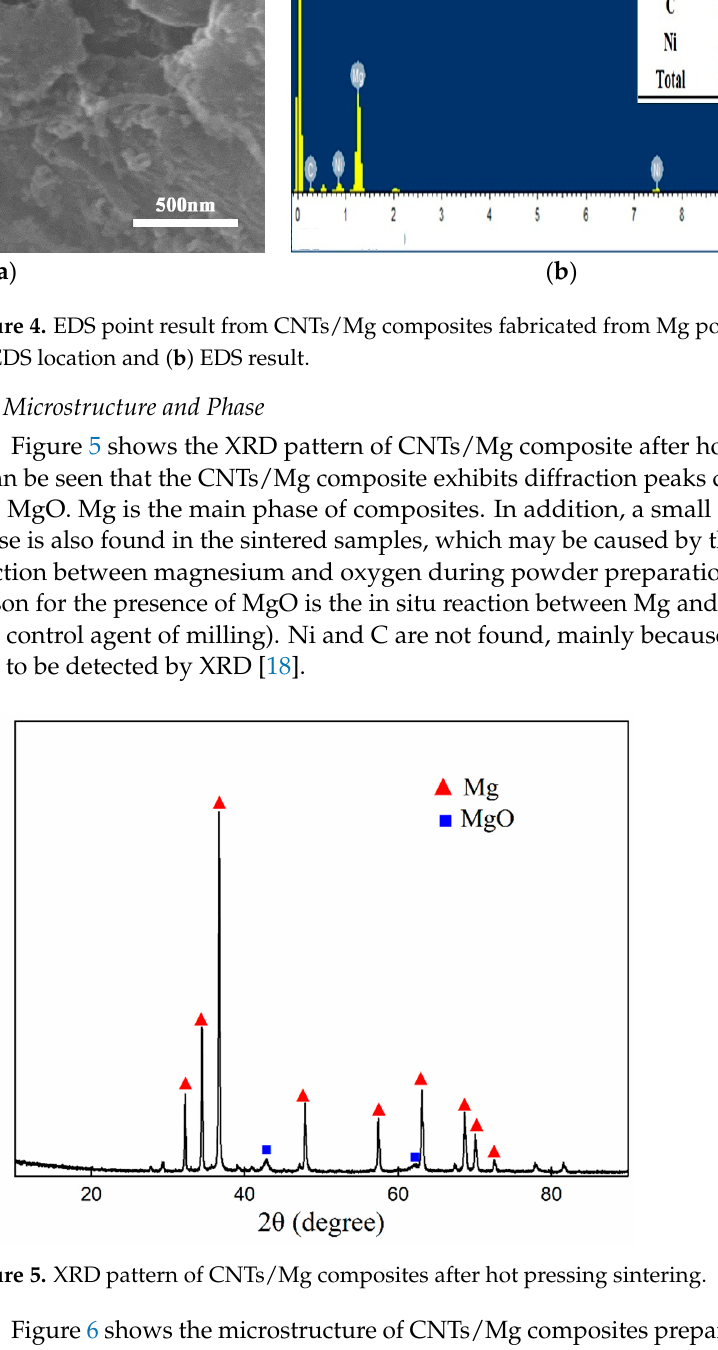
Figure 3. SEM morphology of CNTs/Mg powders with magnesium powders grinded for different times. ( a , b ) as-received, ( c , d ) 15 h, ( e , f ) 30 h, ( g , h ) 45 h and ( i , j ) 60 h.